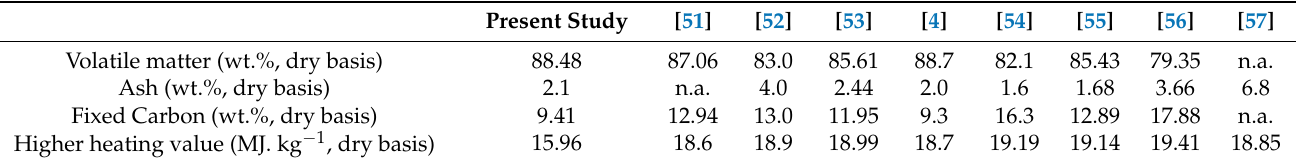
Table 2. Proximate analysis of sugarcane bagasse sample compared with other studies (wt.%, dry basis).